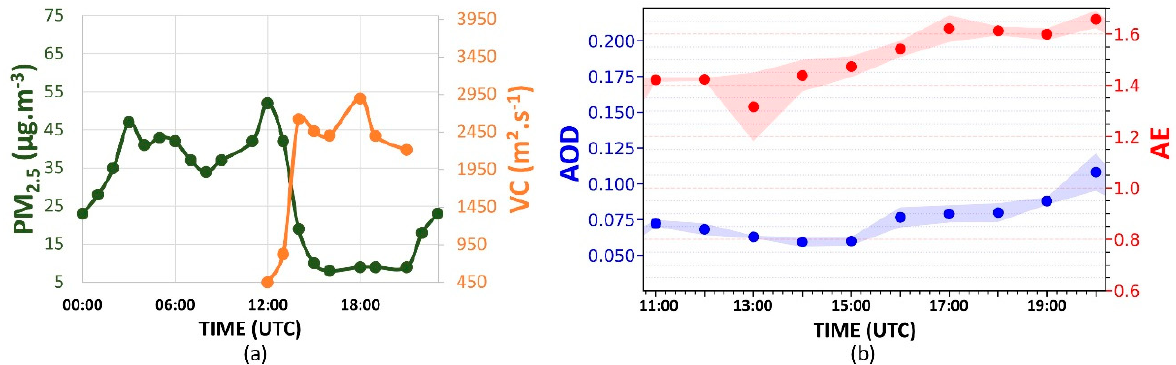
Figure 10. ( a ) Daily cycles of PM 2.5 concentration (green dots) and VC (orange dots); ( b ) AOD at 500 nm (blue points) and AE (440/675) (red points) hourly averages variation from 11:00 UTC to 20:00 UTC, on 23 July 2019. The blue and red shadows represent the AOD and AE standard deviation, respectively. The AERONET data level is 1.5 for AOD and AE.